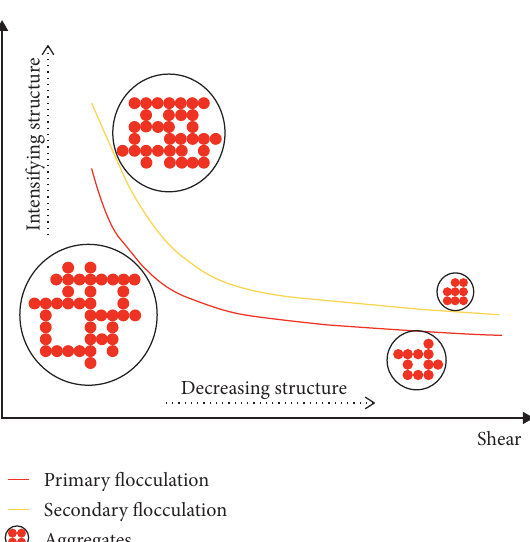
Figure 14: A schematic for the variation of shear-dependent yield stress with shear in the two-step flocculation